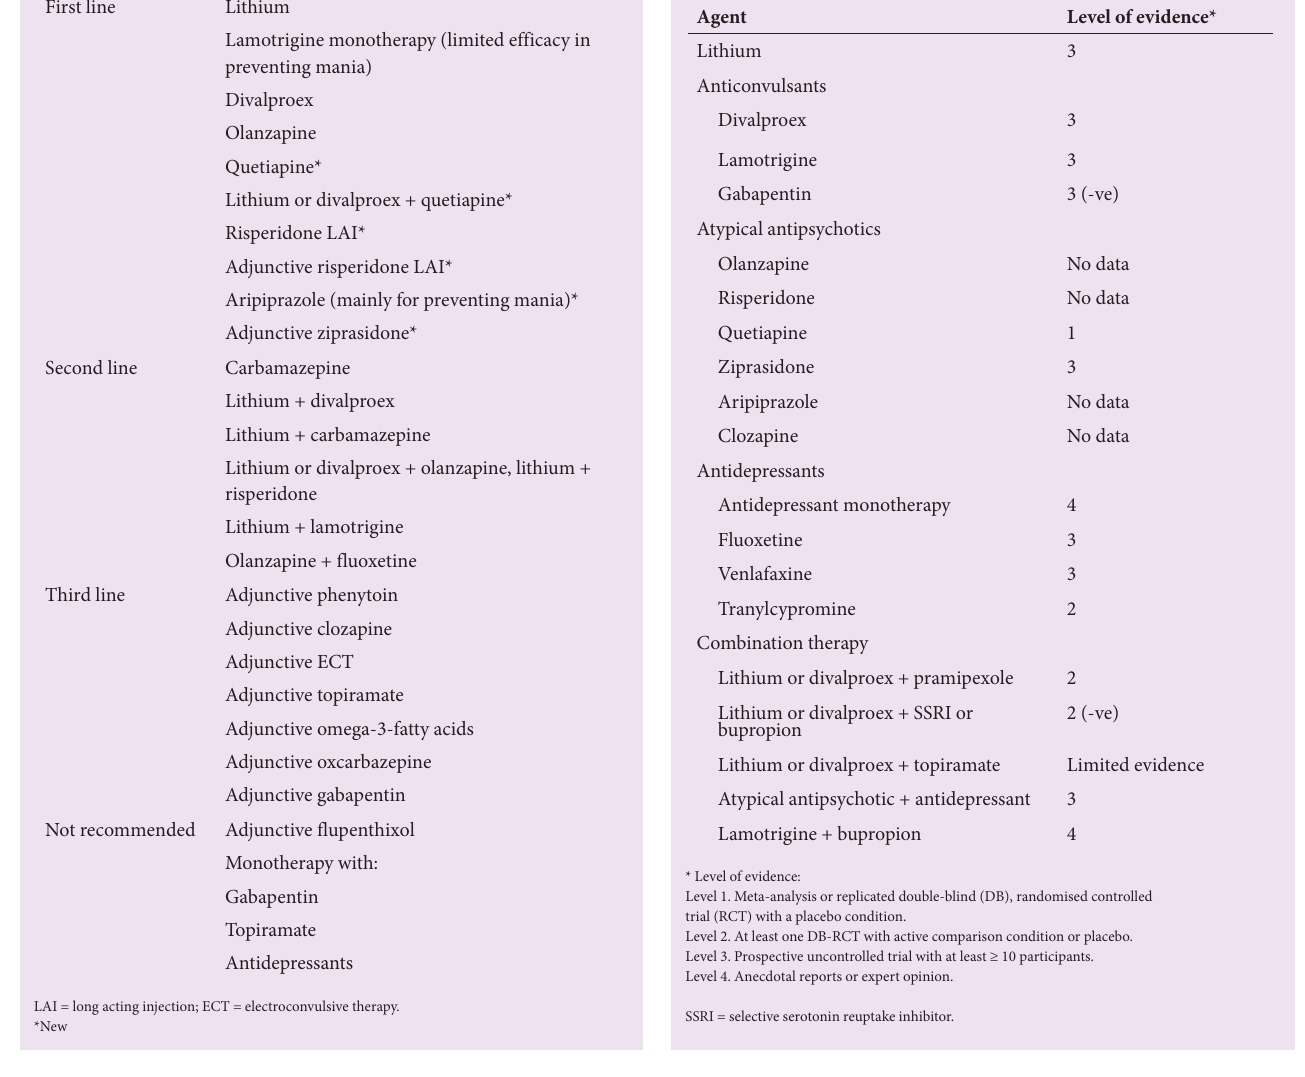
Table 3. Recommendations for maintenance pharmacotherapy Table 4. Strength of evidence for monotherapy treatments